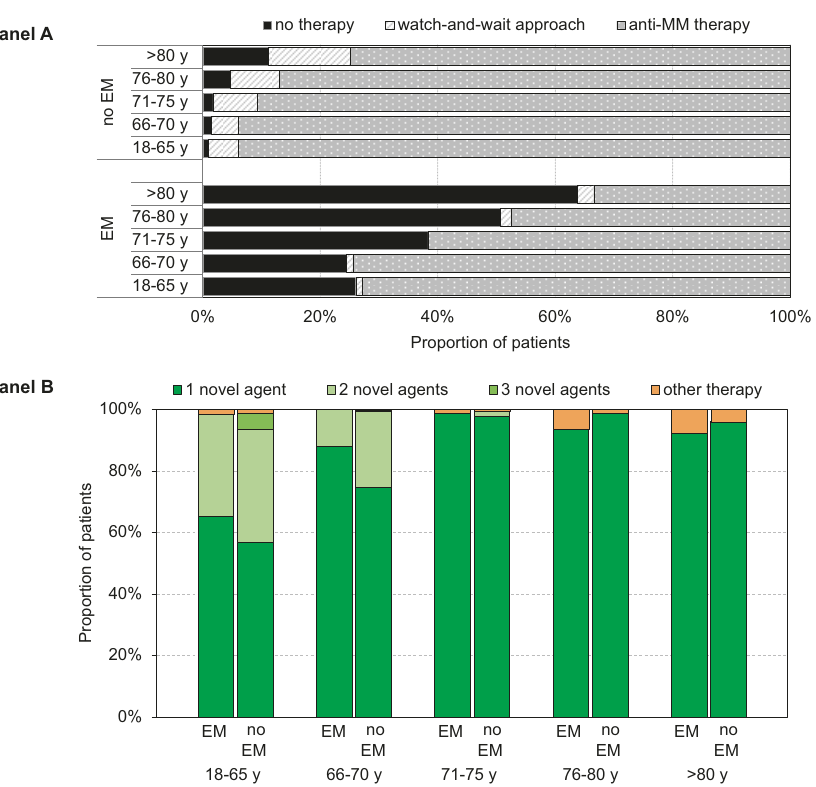
Fig. 2 First-line treatment of patients with multiple myeloma (MM) in the Netherlands, 2014 – 2018. A shows the proportions of MM patients who never received fi rst-line treatment, who were offered a watch-and-wait-approach, or who received anti-MM treatment, according to occurrence of EM and age at diagnosis. B shows the type of fi rst-line regimen (regimen containing 1, 2, 3, or no novel agents) for newly diagnosed MM patients who started anti-MM treatment, according to occurrence of EM and age at